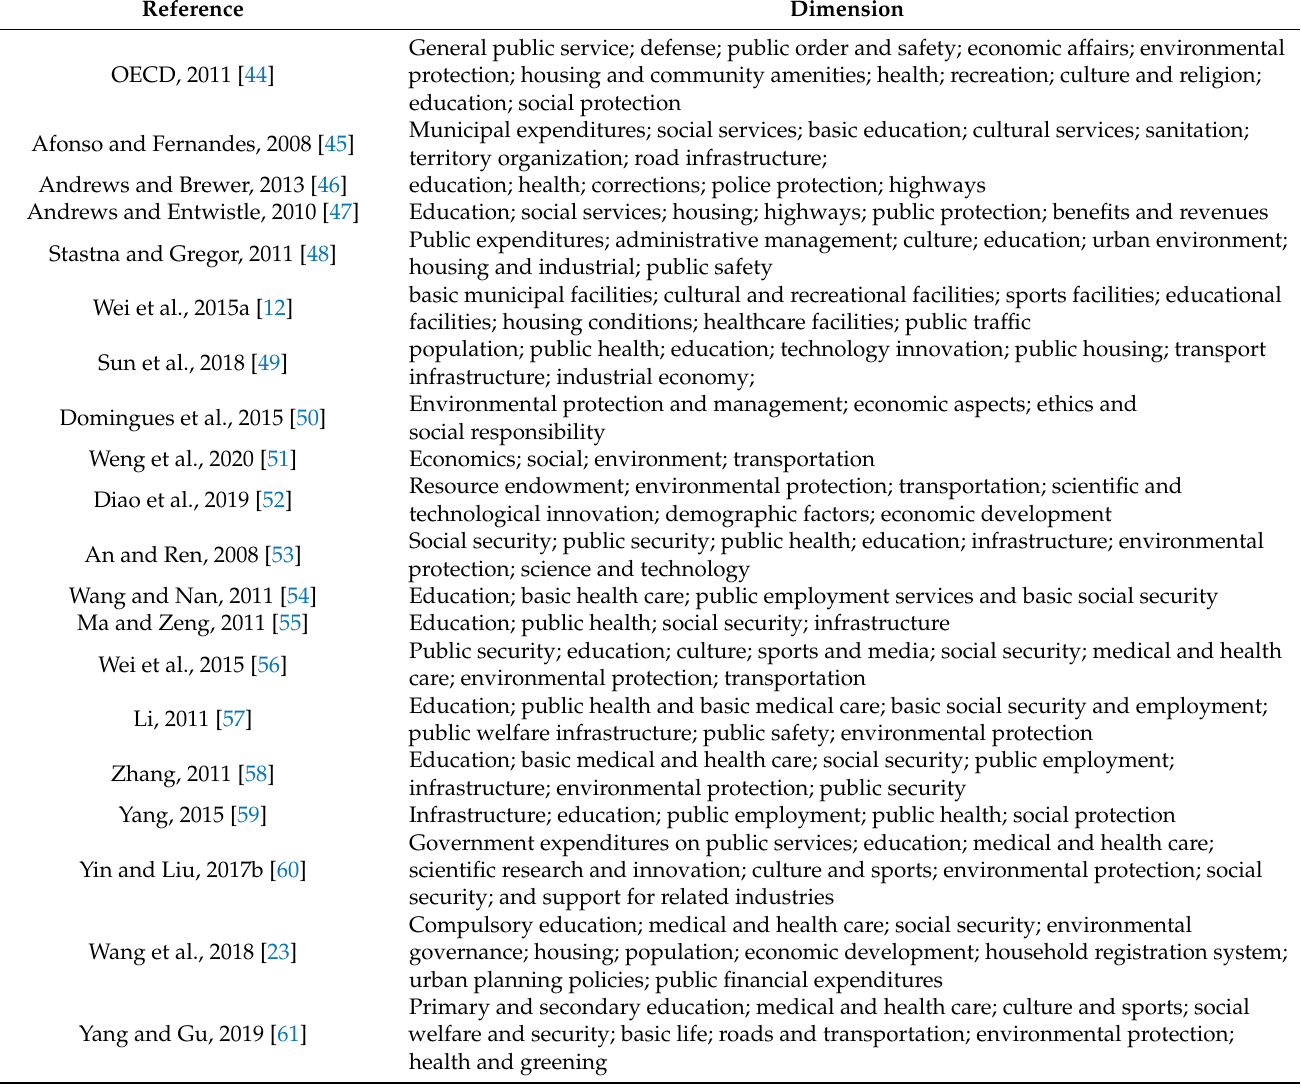
Table 2. Classification of dimensions of UPSCC in existing